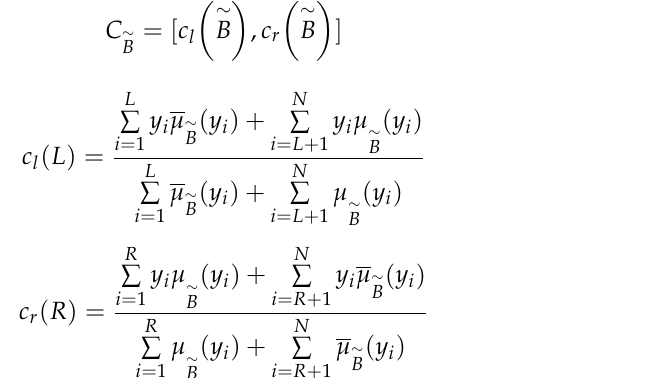
Figure 3. Block diagram describing an IT2FLS.